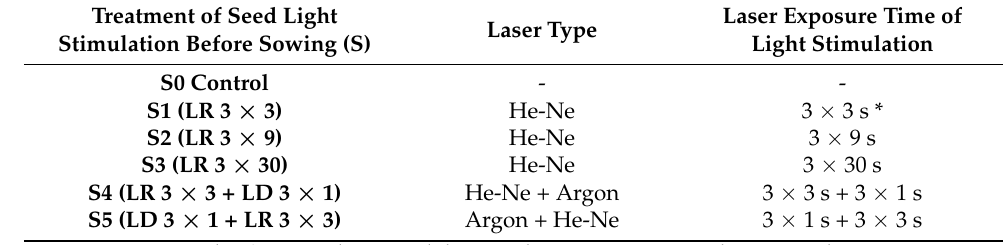
Table 1. Experimental design. Treatment of Seed